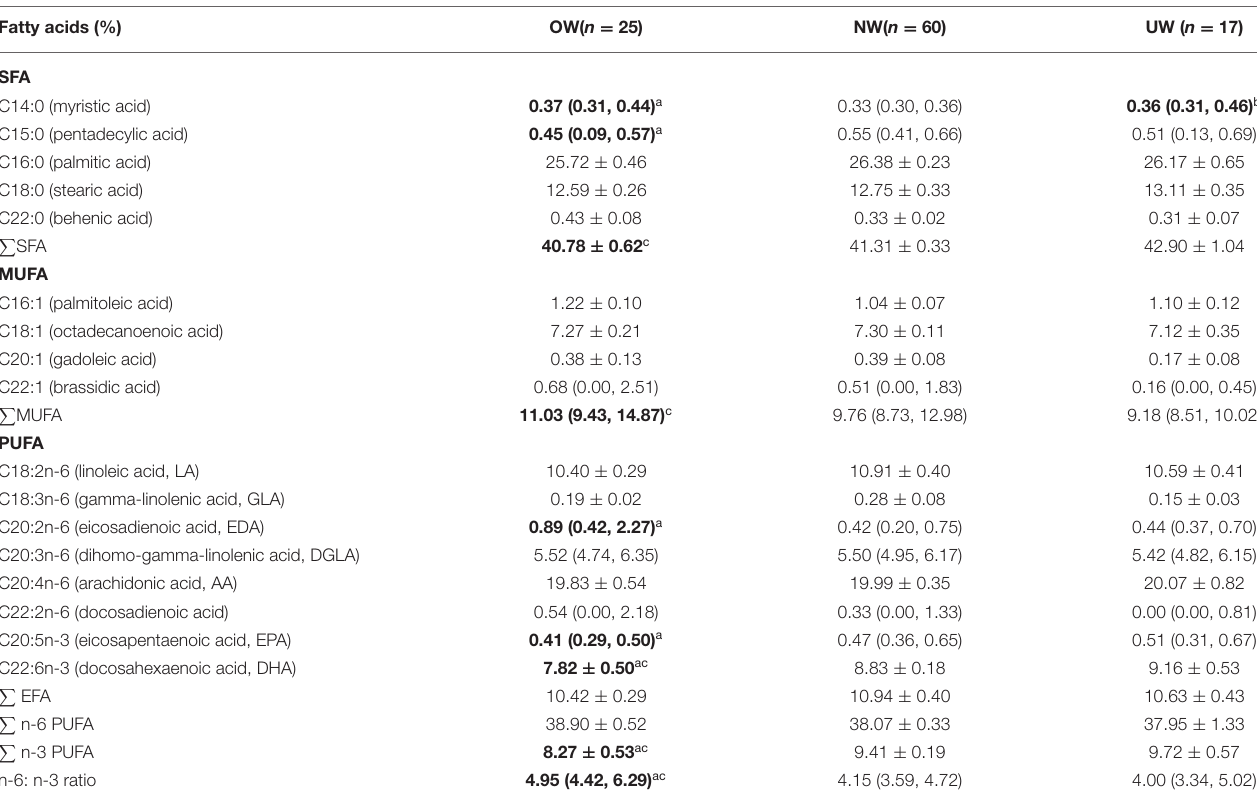
TABLE 3 | The fatty acid profile in fetal cord plasma according to maternal prepregnancy